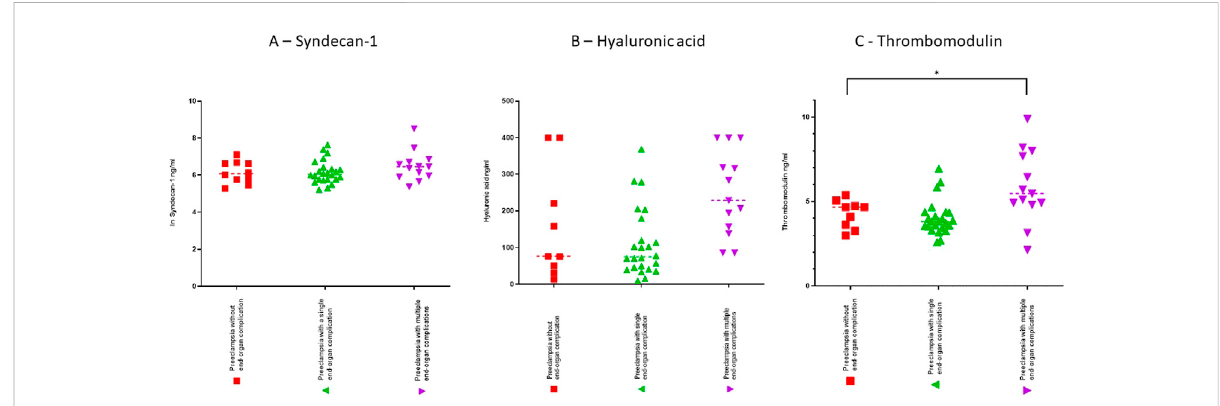
FIGURE 2 Scatterdots showing plasma concentrations with medians for syndecan-1 (A) , hyaluronic acid (B) and thrombomodulin (C) . Syndecan-1 is presented in a logarithmic scale. Preeclampsia without end-organ complications ( n = 10), preeclampsia with a single end-organ complication ( n = 24) and preeclampsia with multiple end-organ complications ( n = 13). * p < 0.05 vs . preeclampsia without end-organ